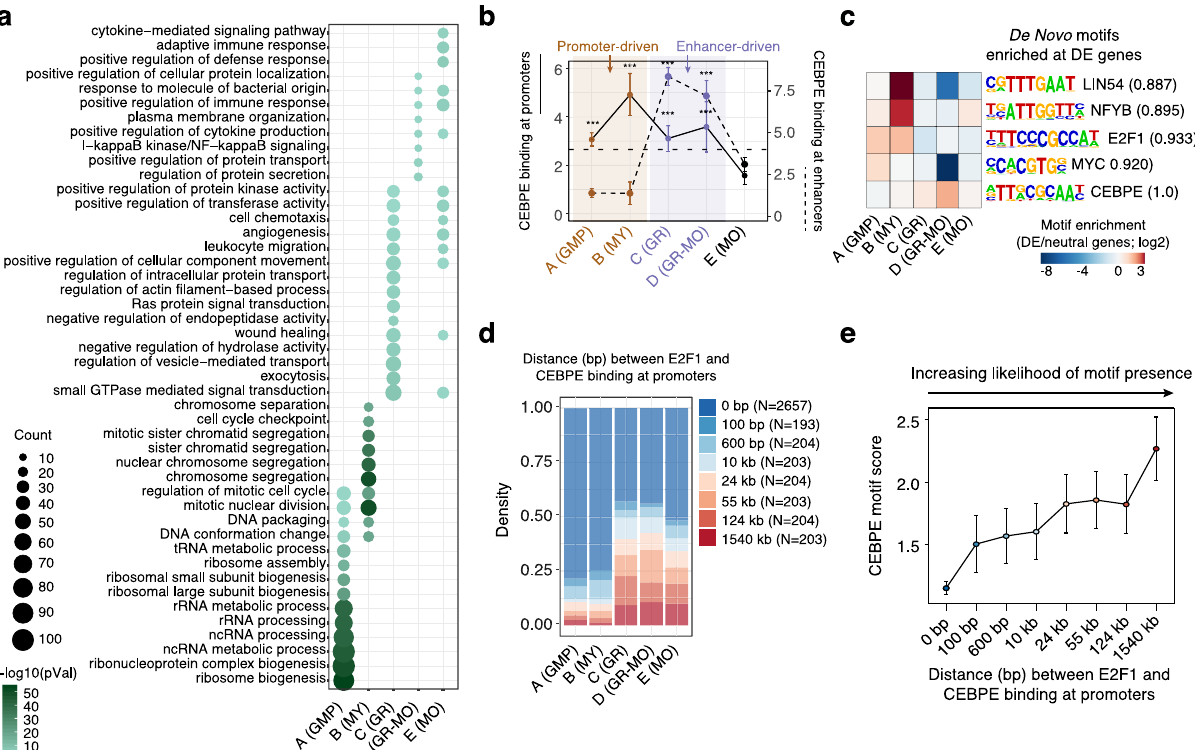
Fig. 3 Speci fi cation of cell identity is regulated at the enhancer level and cell cycle exit at the promoter level. a Functional gene categories of the fi ve gene clusters depicted in Fig. 2a enriched for genes differentially expressed in Cebpe KO vs. Cebpe WT mice. b CEBPE binding signal (median) at promoters (solid lines) and enhancers (dashed lines) of DE genes from the fi ve gene clusters shown in Fig. 2a (median; whiskers represent the standard error; N = 1475 (GMP), 231 (MY), 1401 (GR), 195 (GR-MO), and 695 (MO)). The CEBPE binding signal at enhancer(s) of each gene is normalized to the total number of enhancers linked to the respective gene. *** represent the signi fi cance level ( p < 0.0001) at which the CEBPE binding at the promoters or enhancers of DE genes from a particular class is enriched compared to its binding at the promoters or enhancers of all DE genes ( N = 7903). Wilcoxon test, one-sided, multiple-test corrected using Benjamini – Hochberg procedure. c Assessment of de novo binding motifs enriched at promoters of genes from all fi ve gene clusters that are differentially expressed (DE) in Cebpe KO vs. Cebpe WT mice as compared to genes that were not differentially